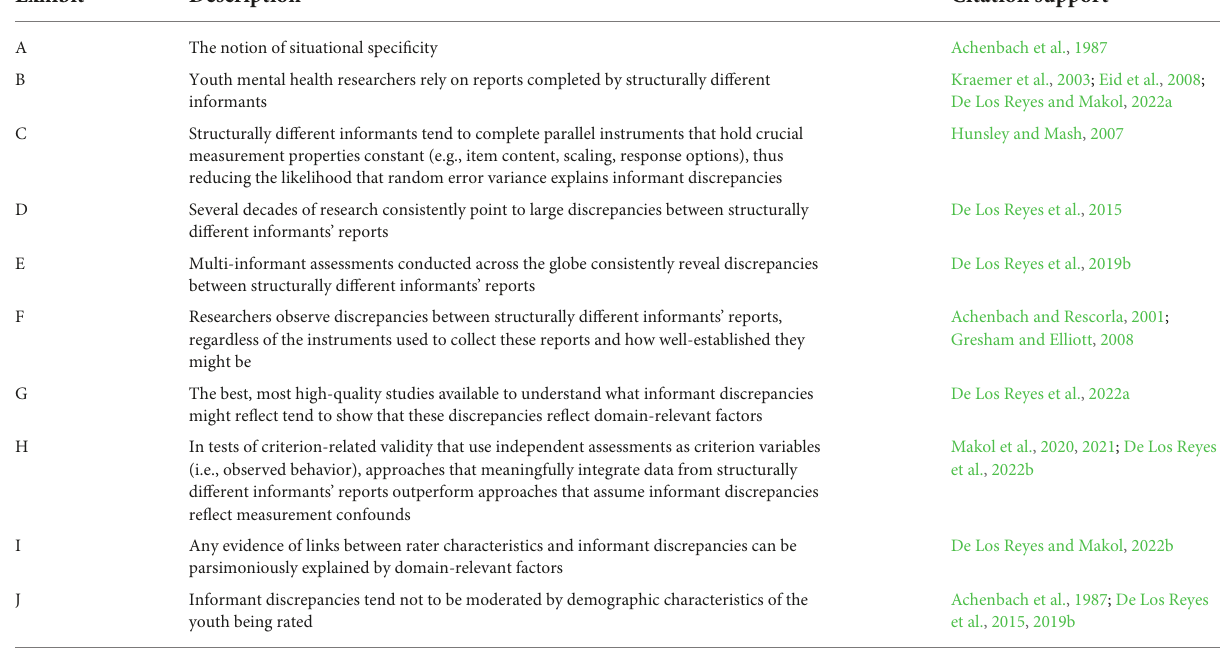
TABLE 1 Pieces of evidence (i.e., exhibits) that point toward informant discrepancies in youth mental health assessments as cases of domain-relevant